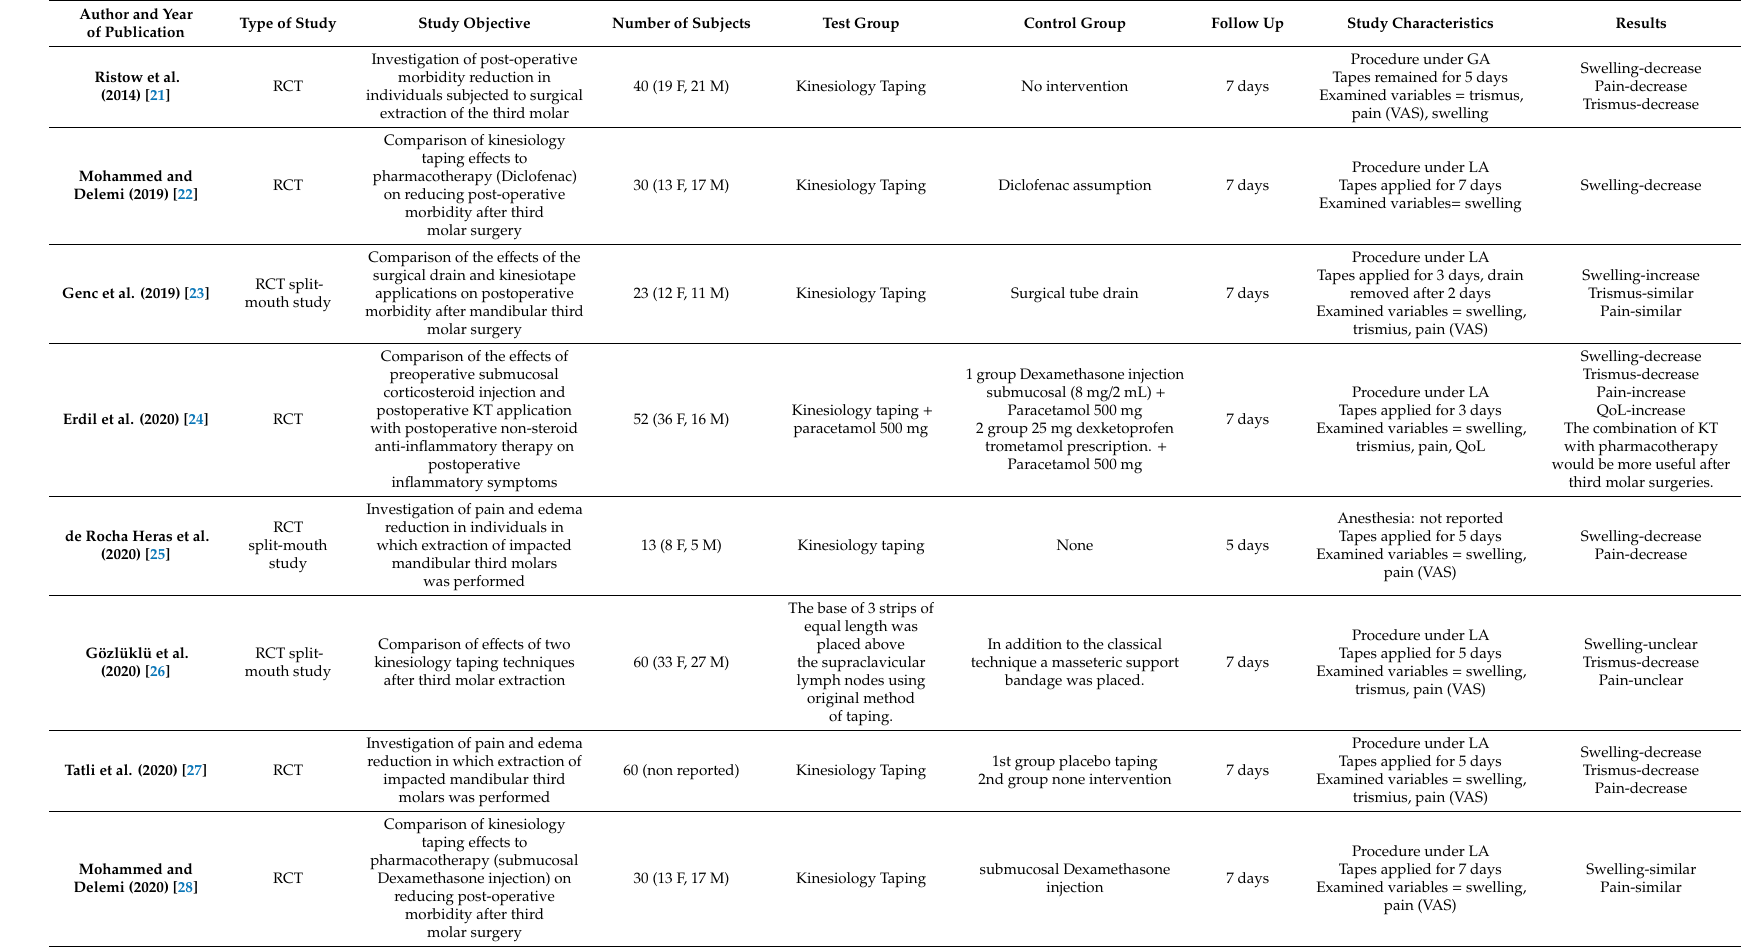
Table 1. Characteristics of included